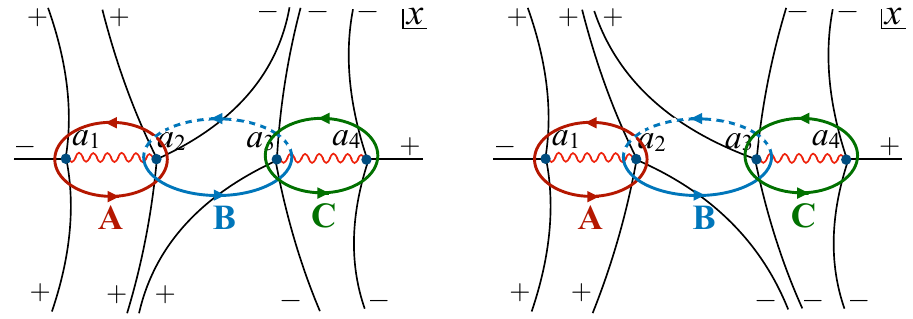
Figure 7 . Perturbative cycles ( A, C ) and a non-perturbative cycle ( B ) for the symmetric double- well potential. The perturbative cycles, A and C , are defined as oriented cycles enclosing ( a 1 , a 2 ) and ( a 3 , a 4 ), respectively, and the non-perturbative cycle, B , is an oriented cycle enclosing ( a 2 , a 3 ) and intersecting with the two branch